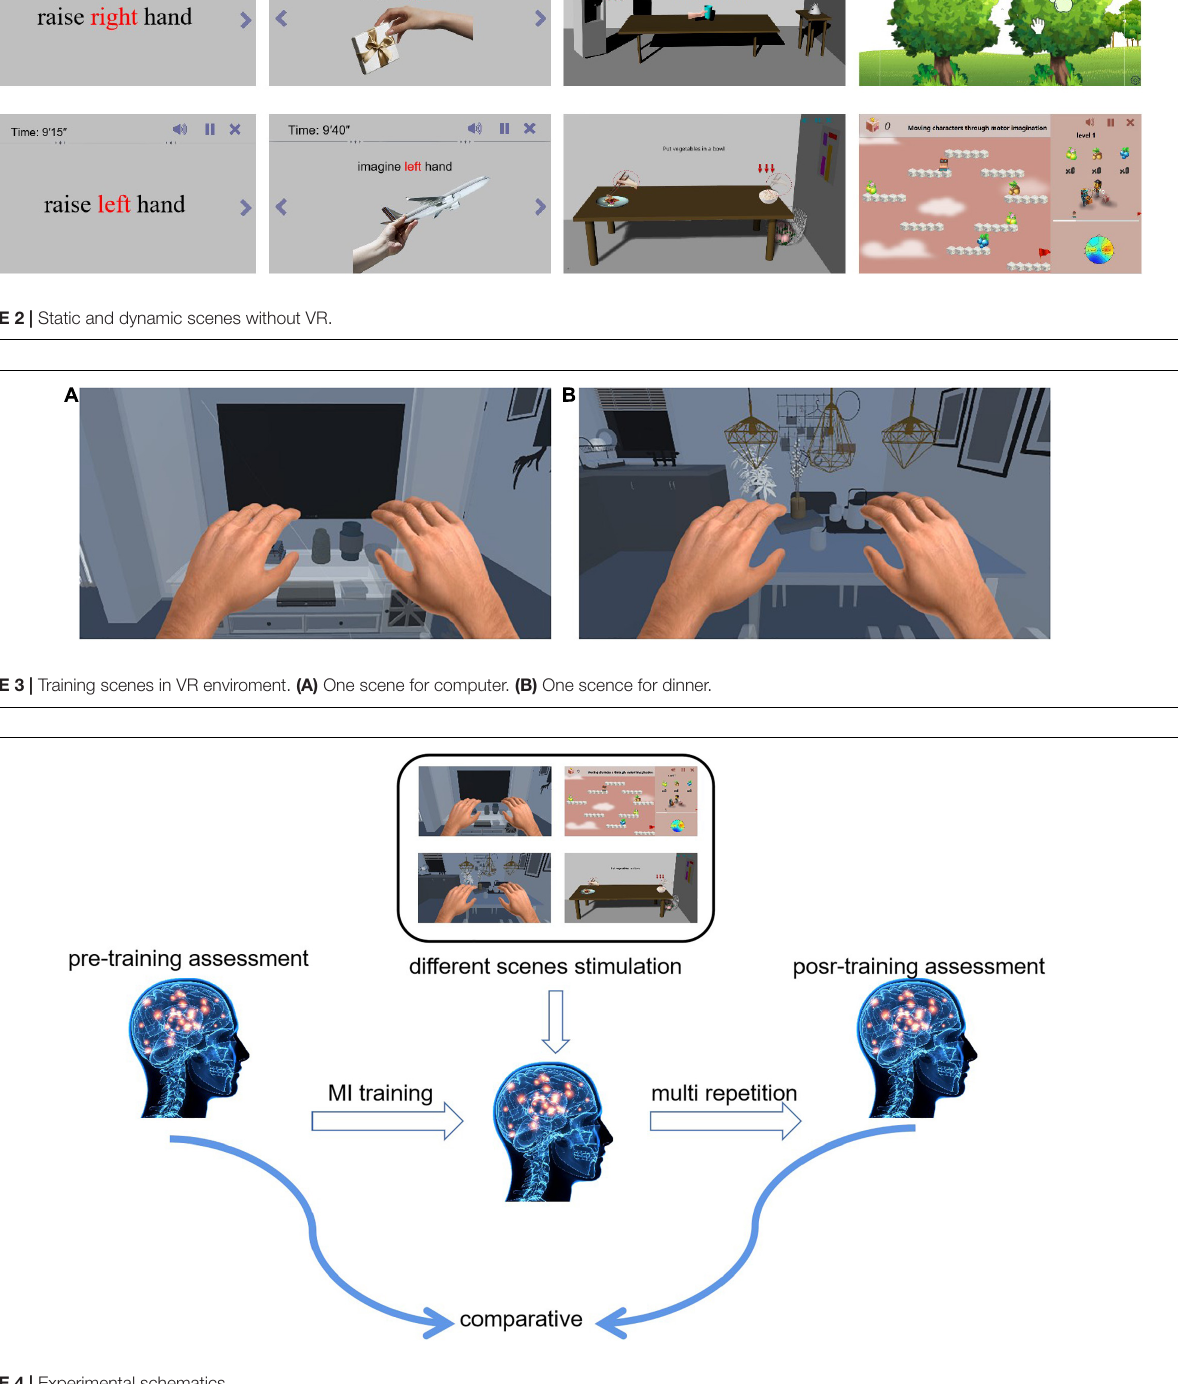
FIGURE 4 | Experimental